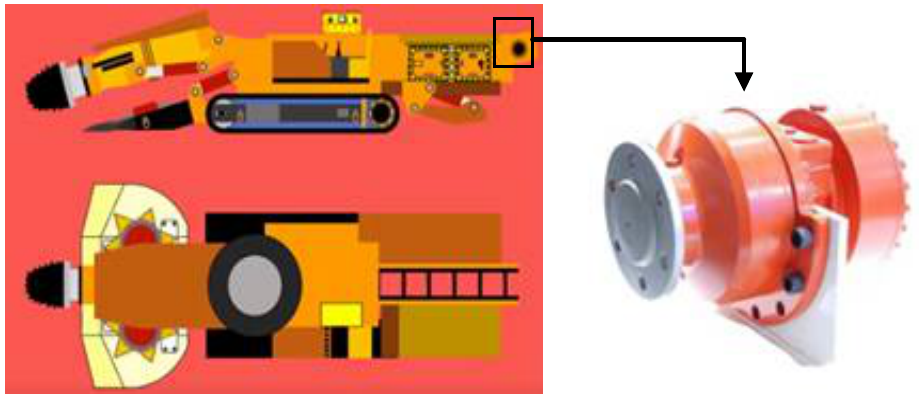
Figure 1. Low-speed, high-torque radial piston motor on a roadheader. Under the action of hydraulic oil force, the motor pushes the piston to reciprocate in the cylinder to realize the continuous rotation of the cylinder. The motor components are shown in Figure 2 and Table